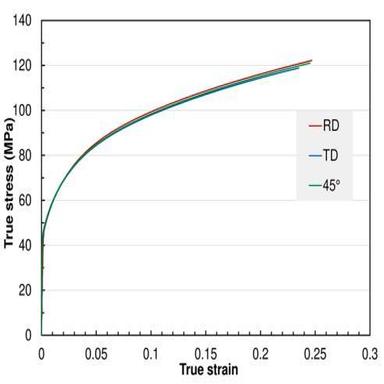
Experimental tensile true stress – true strain curves (color should be used in print).